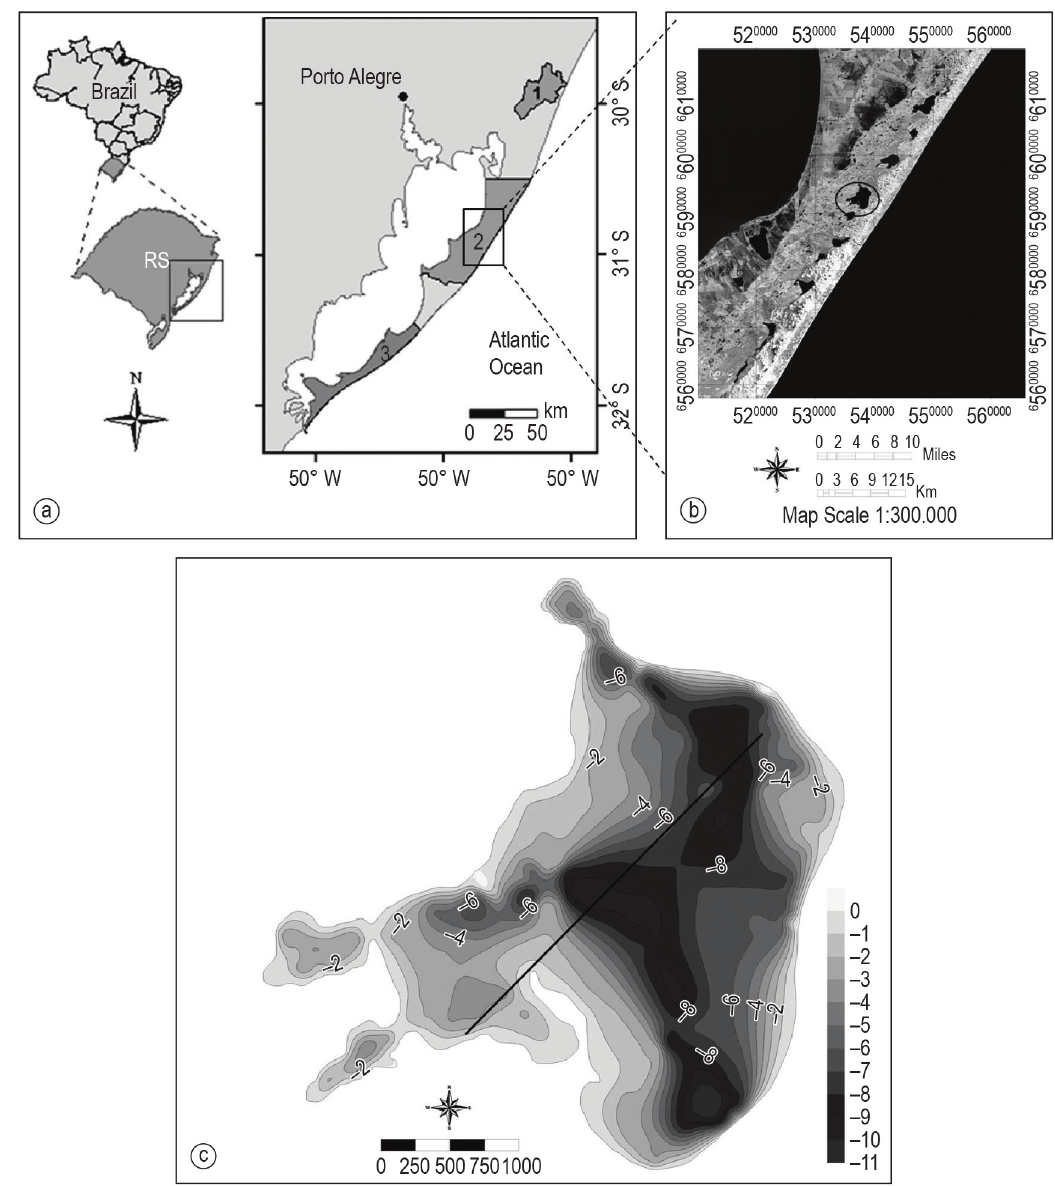
Figure 1. (A) Scope of the study areas of the research group in the municipalities of Osório, the North Coast (1) Mostardas (2) and São José do Norte (3), the East Coast of Rio Grande do Sul; (B) Lake Figueira (circle), munici- pality of Mostardas, central coast Rio Grande do Sul; (C) bathymetric map of Lake Figueira, with sampling